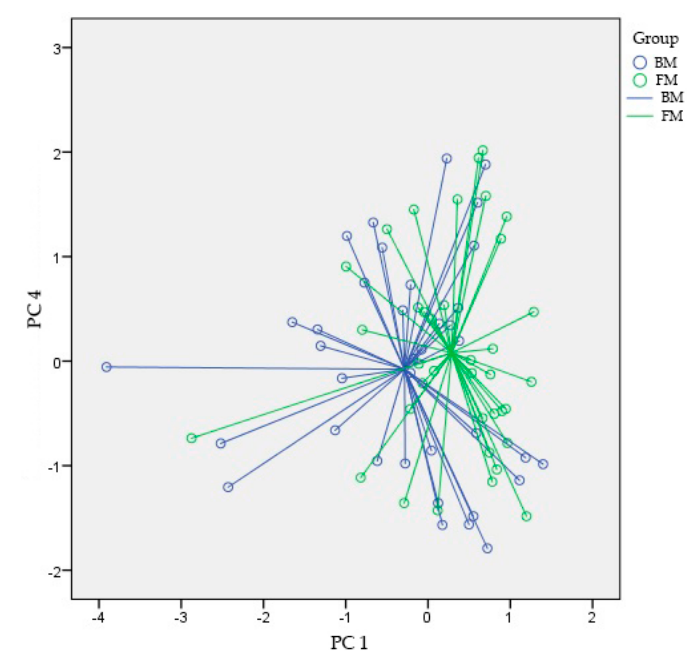
Figure 3. Scatterplot of the best performing principal components for all time-points combined. Abbreviations: BM = breastmilk; FM = formula milk; and PC = principal component.